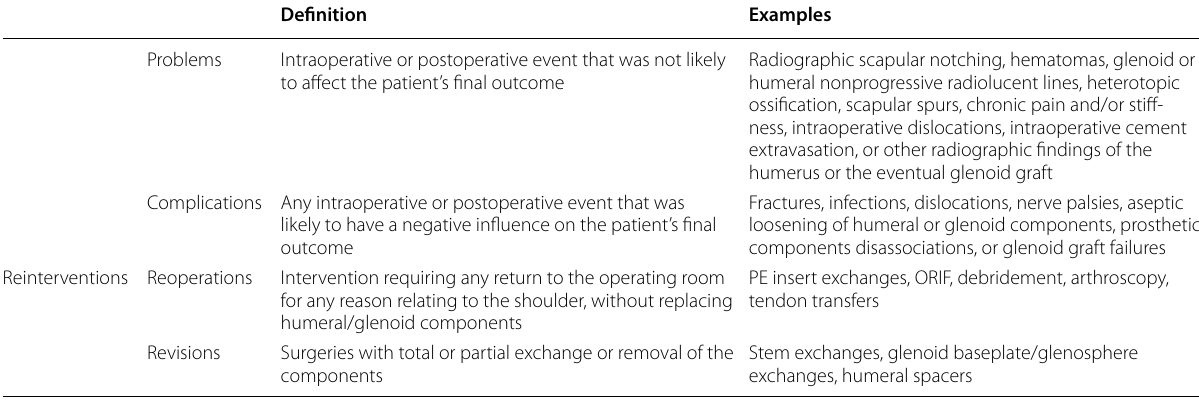
PE polyethylene insert, ORIF open reduction internal